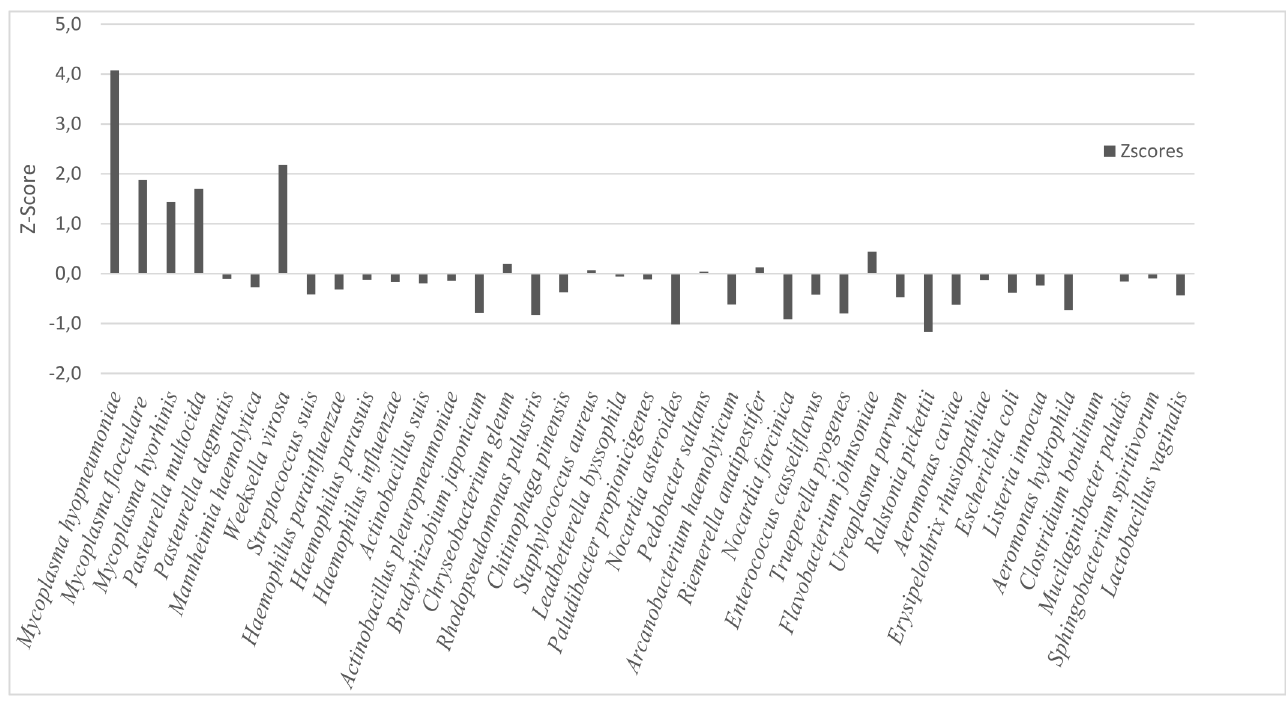
PLOS ONE | https://doi.org/10.1371/journal.pone.0181503 July 18,